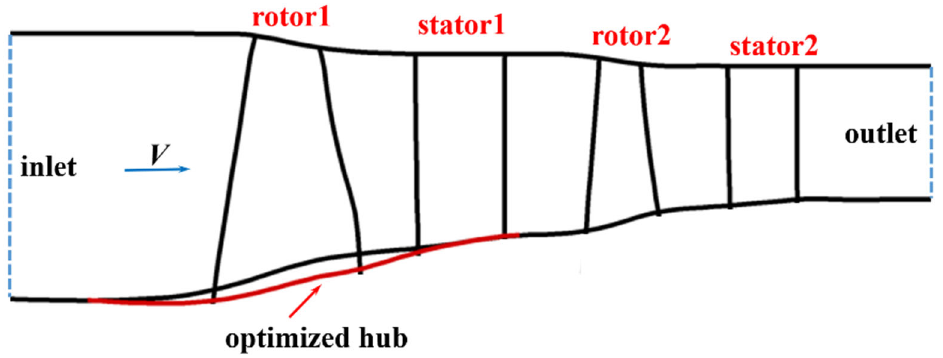
Figure 11. The schematic diagram of the optimized hub profile.